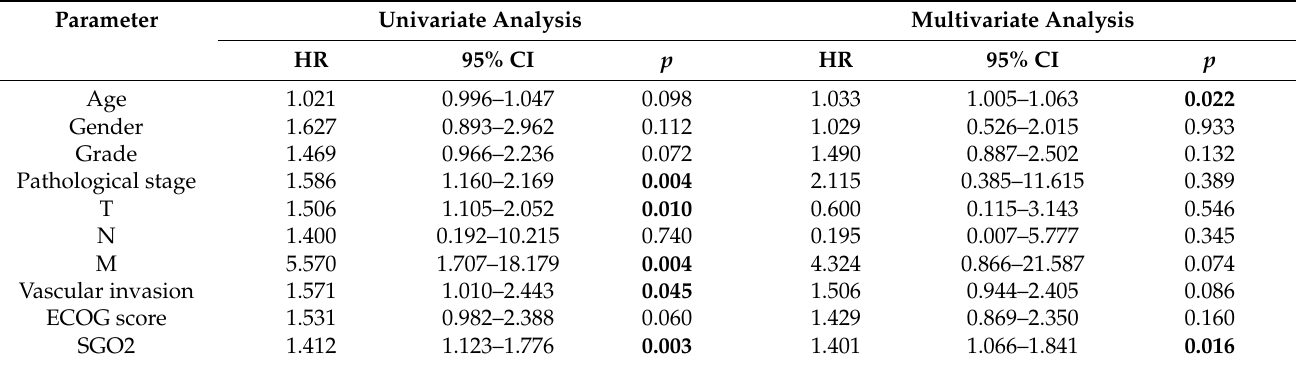
Table 4. Univariate analysis and multivariate analysis of the correlation of the SGO2 expressions among HCC patients. Parameter